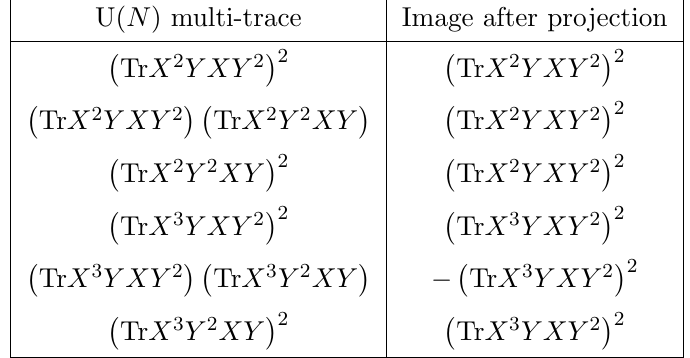
Table 7 . Examples of projections of individual U( N ) multi-traces.